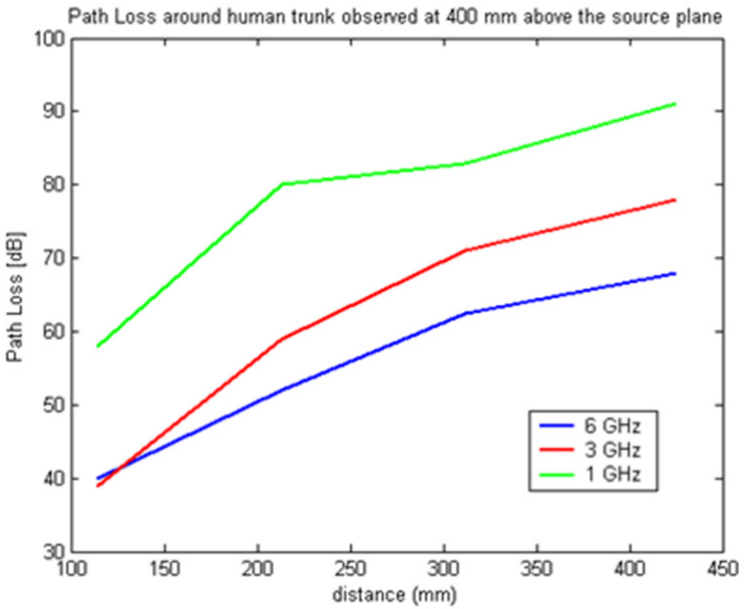
Figure 9. Path loss versus separation distance with receiving antenna 400 mm above the source